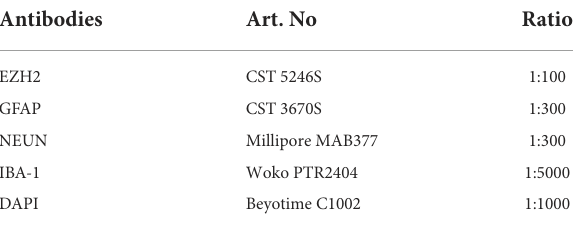
TABLE 2 Primary